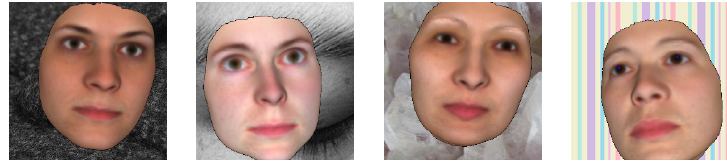
Figure 9. FaceGen facial images with random textures as